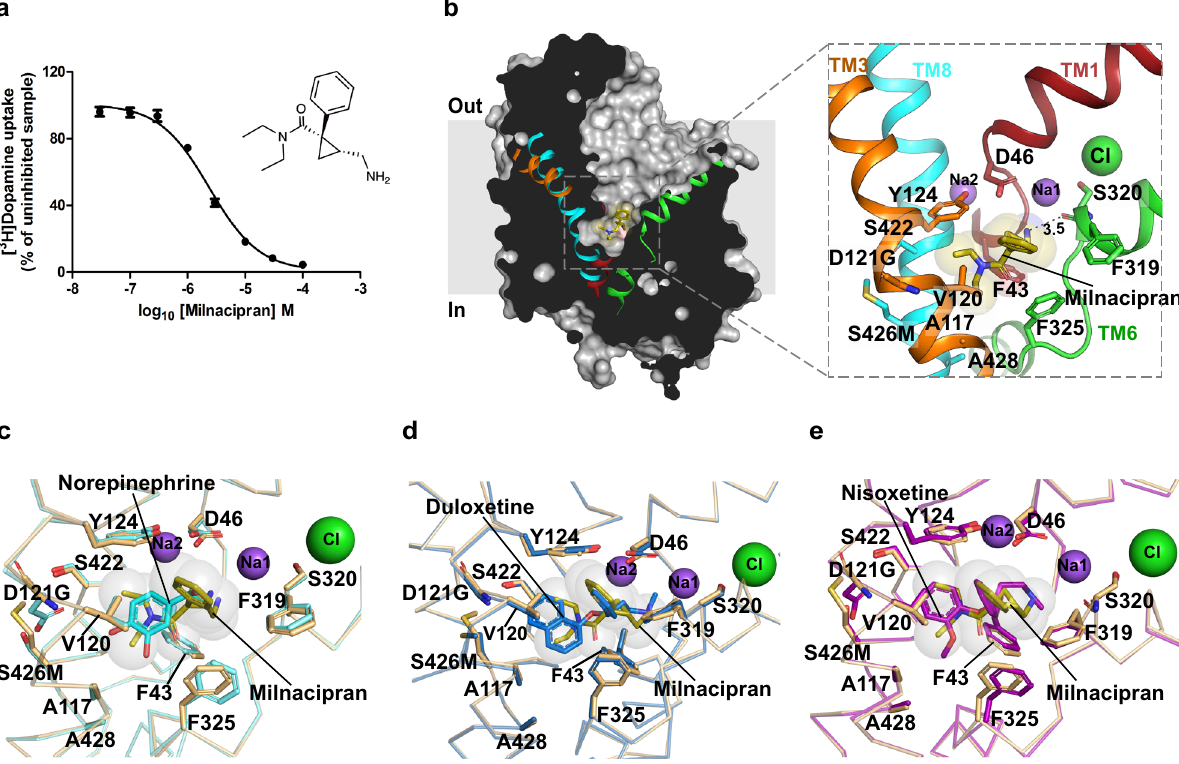
Fig. 4 Milnacipran is a competitive inhibitor of NE uptake. a [ 3 H] dopamine transport inhibition by increasing concentrations of 1R-2S milnacipran with a K i value of 1.5 ± 0.1 μ M (data in the plot are a mean of n = 9 measurements obtained over three independent experiments and error bars representing s.e.m). Inset displays the chemical structure of 1R-2S milnacipran. b Longitudinal section of dDAT NET in complex with milnacipran-bound (olive sticks) in the primary binding site with residues in proximity displayed as sticks. c Milnacipran-binding pose compared with NE binding in dDAT mfc reveals an angular shift of F325 by 35° to retain hydrophobic interactions with the diethyl group of milnacipran. d Milnacipran-bound dDAT NET vs duloxetine-bound dDAT subB display identical positions of the surrounding residues. e Structural overlap of nisoxetine bound dDAT (PDB id. 4XNU) with milnacipran-bound dDAT subB , revealing the surrounding residues in identical binding positions. Source data are provided as a Source Data fi